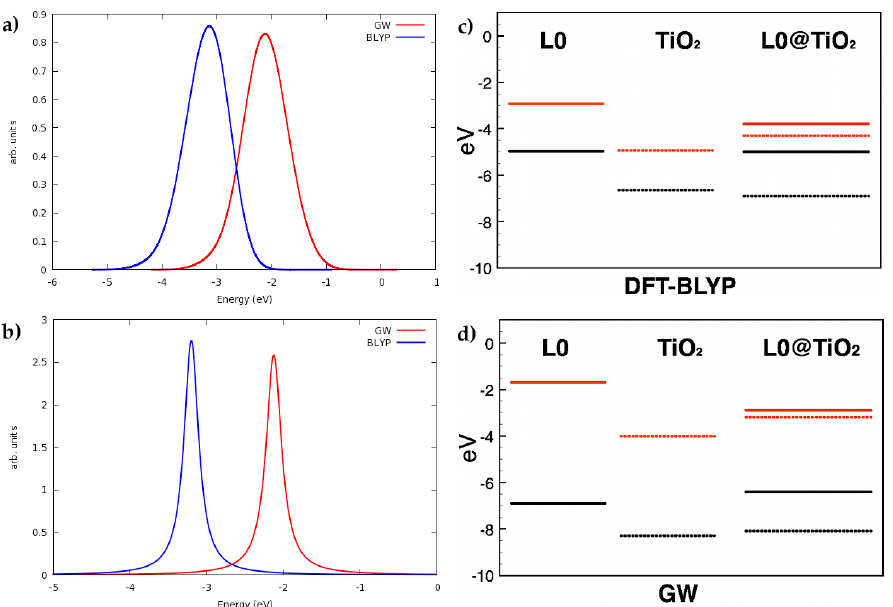
Figure 7. ( left ) L0@TiO 2 PDOS ( a ) and corresponding Lorentzian distribution ( b ) of the dye’s LUMO. A Gaussian broadening of 0.3 eV has been used for the PDOS simulation (see text); ( right ) Position with respect to vacuum of the energy levels of the HOMO (bold-black) and LUMO (bold-red) of the L0 dye, and the VBM (dotted-black) and CBM (dotted-red) of the TiO 2 slab, reported for the isolated L0 dye, the sole slab, and the L0 dye adsorbed on the anatase TiO 2 (101) surface. ( c ) calculated with DFT-BLYP and ( d ) with the GW method. Adapted from [74].